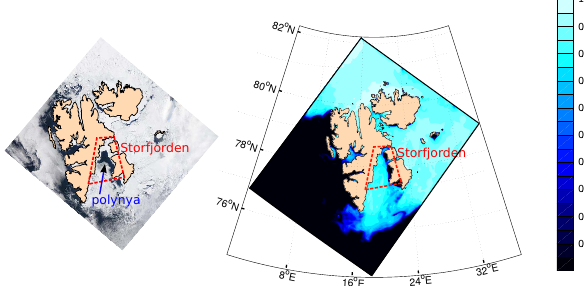
Figure 8. (Left)satellite MODIS image of the Svalbard Archipelago (22 May 2002). Note that clouds and sea ice are both white. (Right) 1-day averaged simulated sea ice concentrations at the same date from the high-resolution regional simulation. In both pictures, ice is pushed away from the shore by northeasterly winds, allowing formation of a polynya along the east coast of